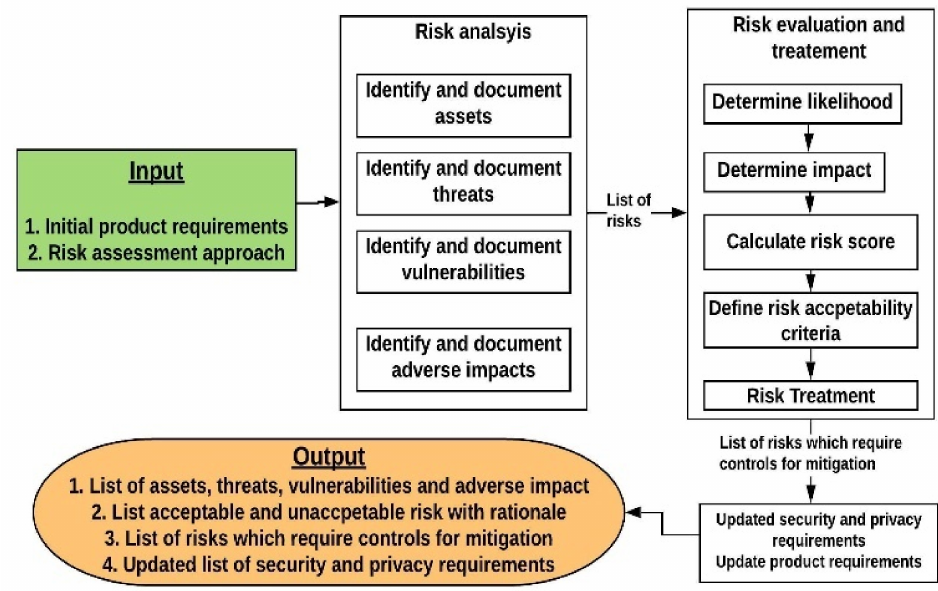
Figure 6. Security and privacy risk assessment steps in the requirement analysis phase.